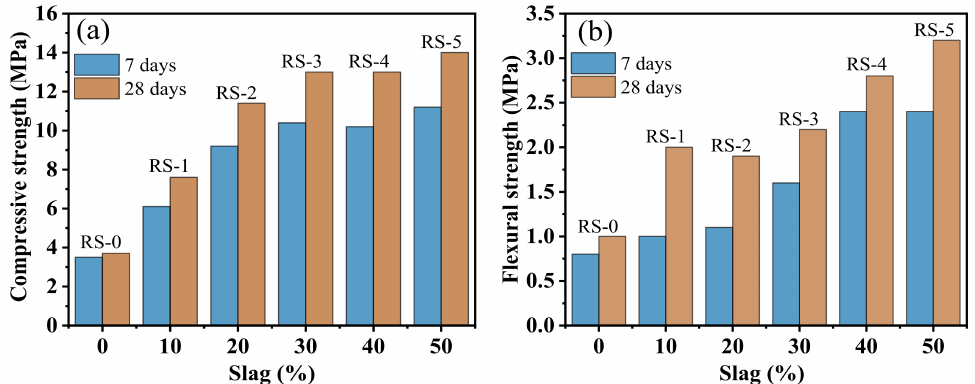
Figure 4. ( a ) Compressive strength and ( b ) flexural strength of composite cementitious material at 7 days and 28 days with different slag